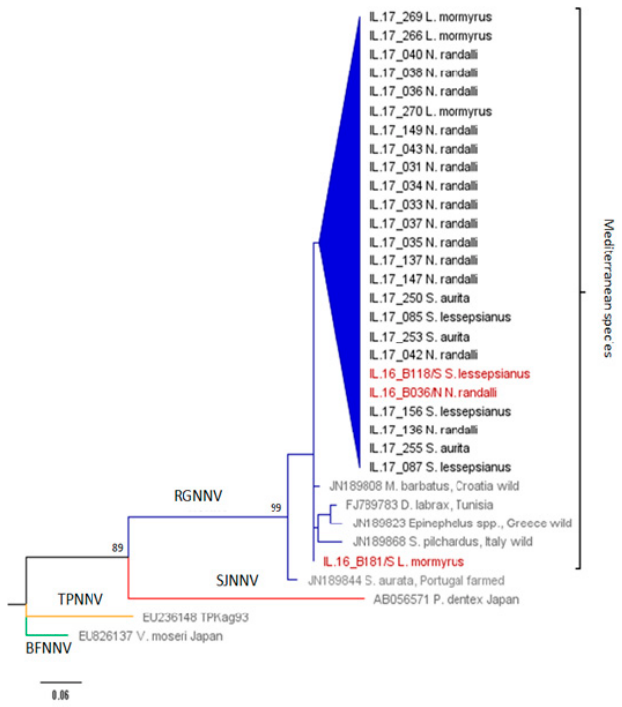
Figure 2. RNA1 phylogenetic tree. Maximum likelihood (ML) phylogenetic tree of the RNA1 partial sequences. The sequence name includes the identification number and host species. Positive samples of this study (begins with IL) are in black, reference sequences from GenBank are in grey, and representative sequences from 2016 [21] are in red. NNV genotype subdivision is displayed on the branches (blue: RGNNV; green: BFNNV; yellow: TPNNV; red: SJNNV).Vertical brace designate subclustering of samples from the Mediterranean Sea. The numbers at the branches nodes represent bootstrap values (only values ≥ 70% are reported). The scale bar represents 0.06 nucleotide substitution per site.